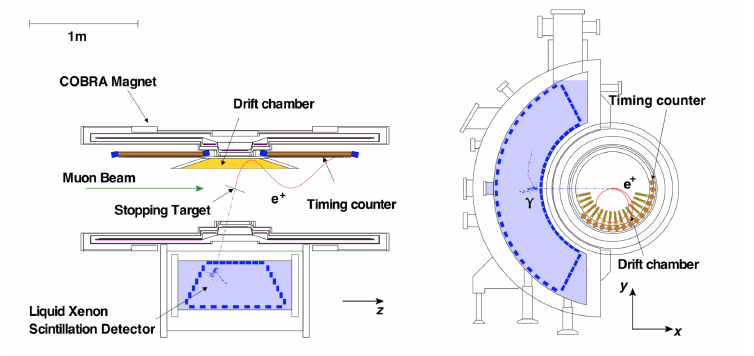
Figure 13. Schematic of the MEG experiment (Figure from [101]). Table 4. Summary of detector performance for the MEG and MEG-II experiments [102]. σ X indicates the resolution of the observable X , (cid:101) X the detection efficiency for the particle X . For the case of the photon energy resolution σ E , the two values refer to the shallow ( < 2 cm)/deep ( > 2 cm) events. σ t γ is the time resolution on the e + − γ time residual. The reported values for the MEG-II case refer to the updated results from the engineering runs reported in